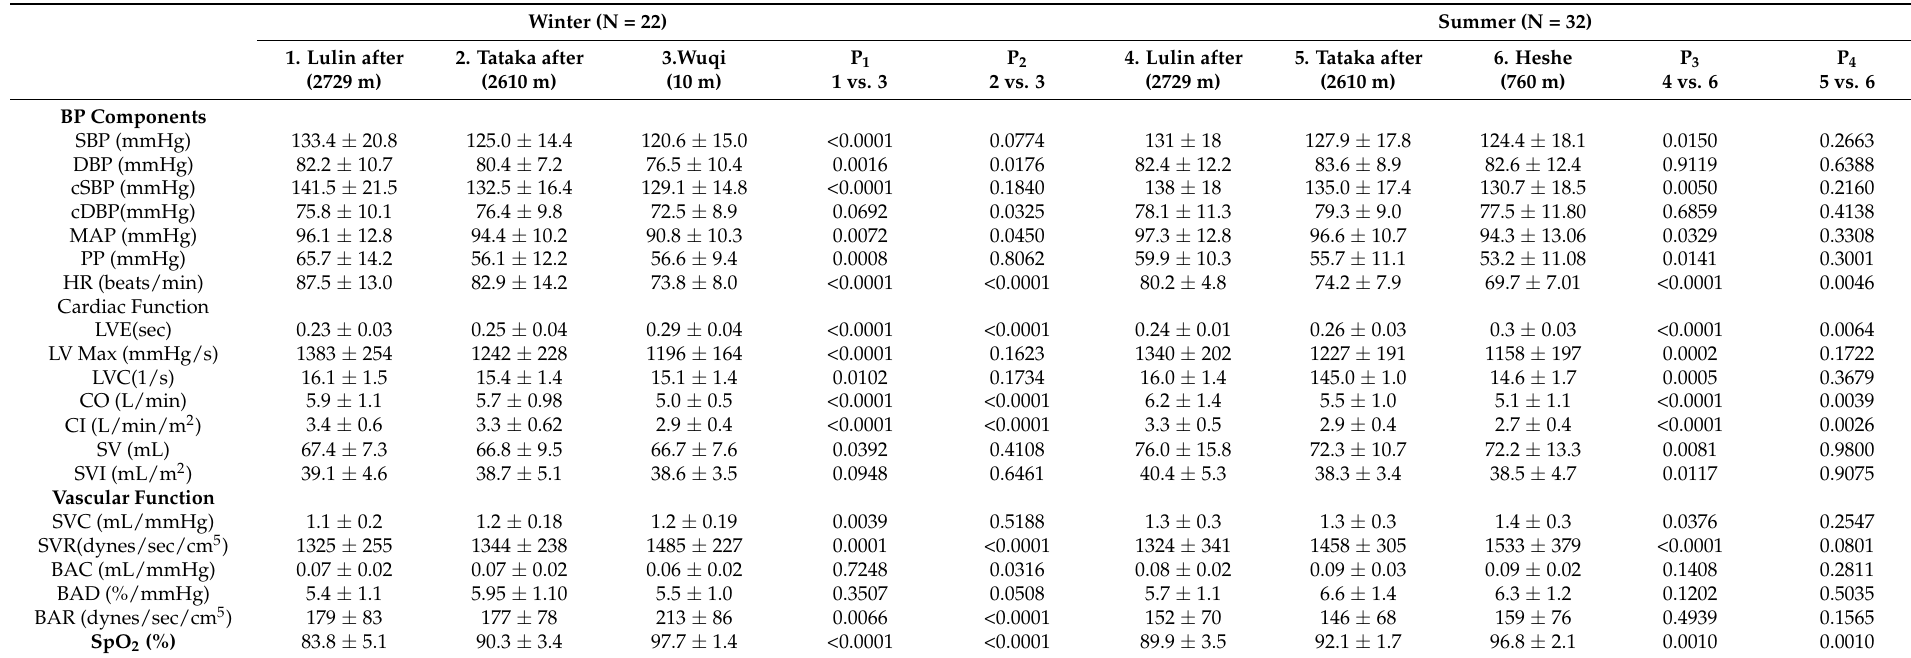
Table 4. Comparisons of cardiac function and hemodynamic parameters descending from high to low altitude in winter and